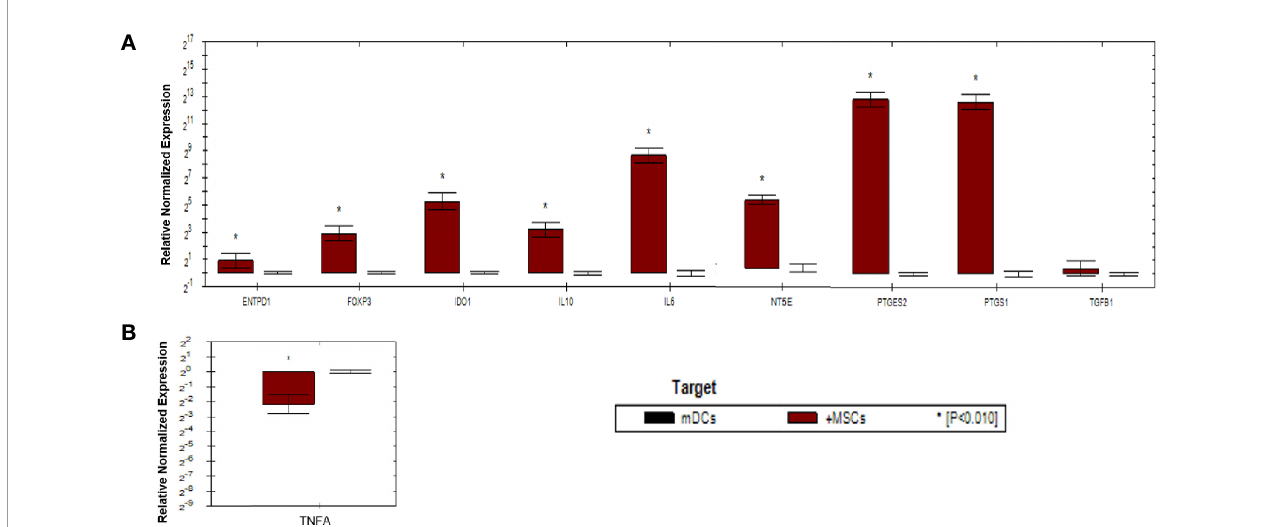
FIGURE 5 | Relative normalized expression of immunomodulatory and immunostimulatory genes of mDCs after co-cultured with primed WJ-MSCs. (A) upregulated genes. (B) downregulated gene. Mature dendritic cells from four patients were used. Results were normalized to 18S rRNA Each sample was performed in triplicate, and a mean value was calculated. Data were analyzed according to 2 − DD CT method using CFX Maestro ™ Software - Bio-Rad. * p ≤ 0.01 and fold change ≥